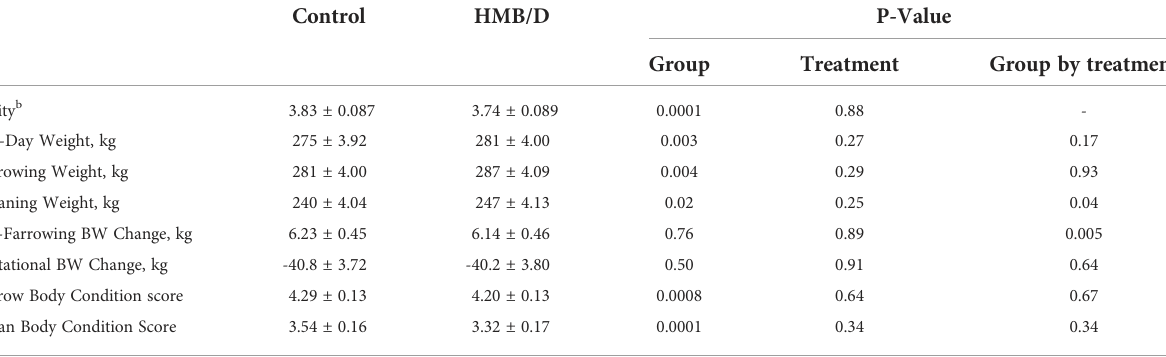
TABLE 3 The effect of supplementing calcium beta-hydroxy-beta-methylbutyrate and vitamin D (HMB/D) during late gestation and lactation on sow weights and condition. a Control